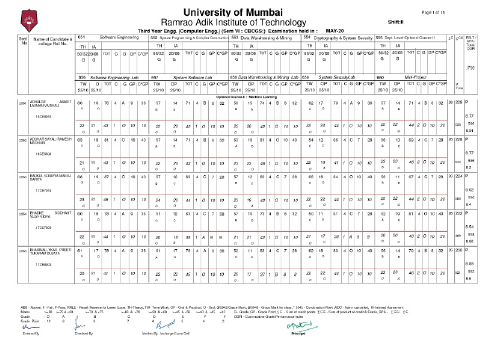
Figure 1. Exam Result Gazette